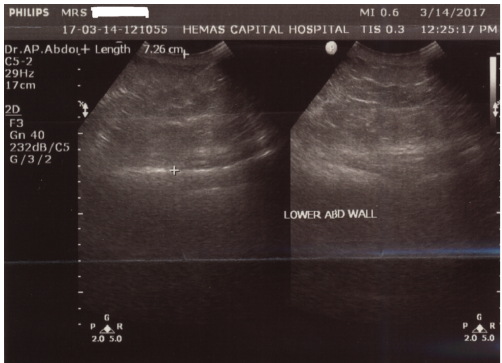
Figure 1: Ultrasound scan of the abdomen showing extensive abdominal wall oedema.